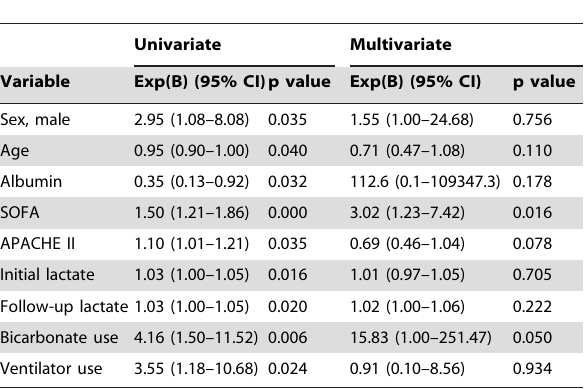
Table 4. Logistic regression analysis for factors that affect